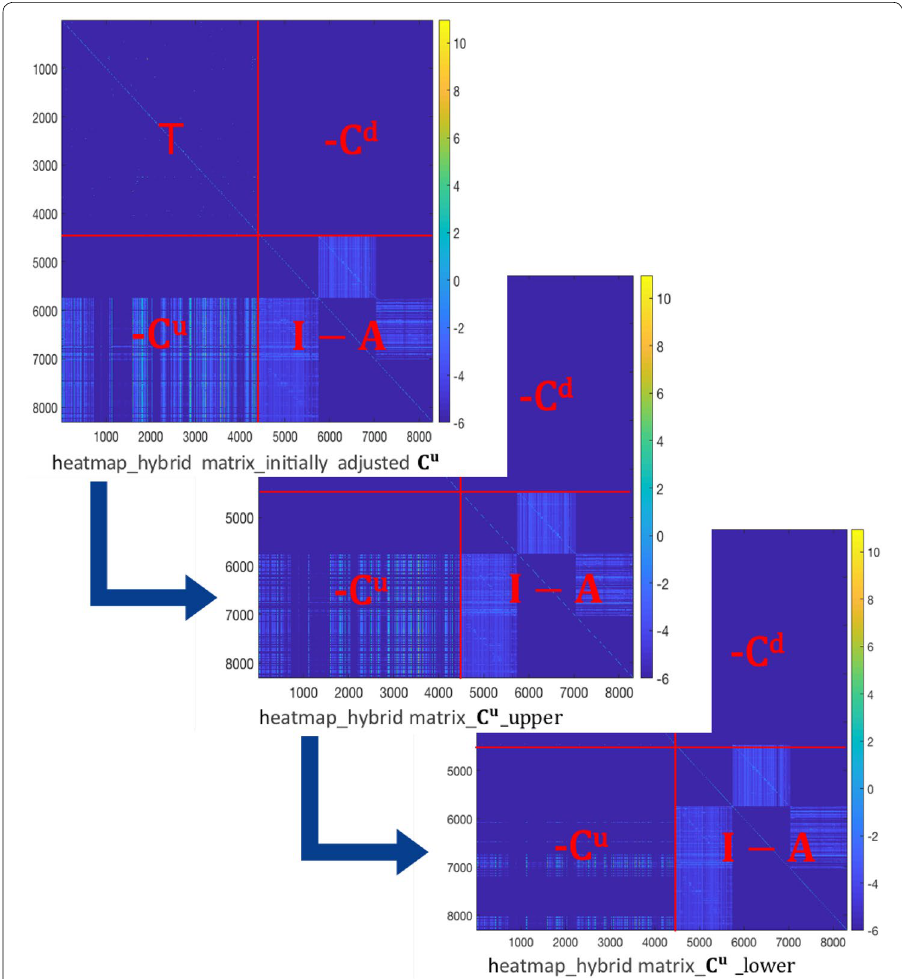
Fig. 6 Heatmaps of the hybrid matrix, showing how the upstream cut-off matrix C u is populated under different scenarios for double-counting